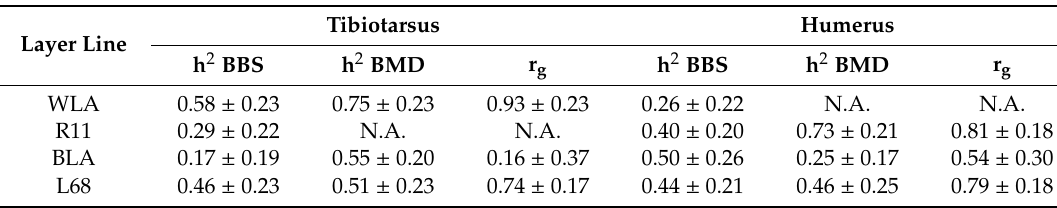
Table 4. Heritability (h 2 ; ± standard error) and genetic correlation (r g ; ± standard error) estimated for bone breaking strength (BBS) and bone mineral density (BMD) of tibiotarsus and humerus in four chicken layer